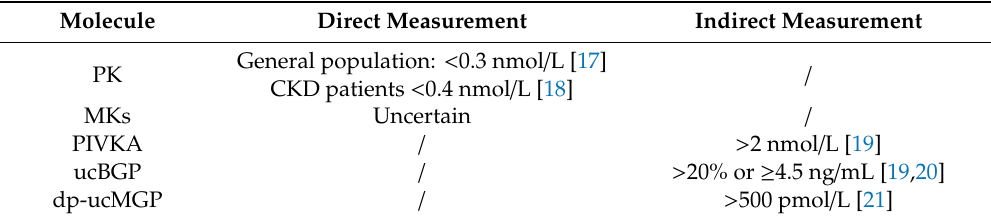
Table 1. Levels of molecules defining vitamin K deficiency.